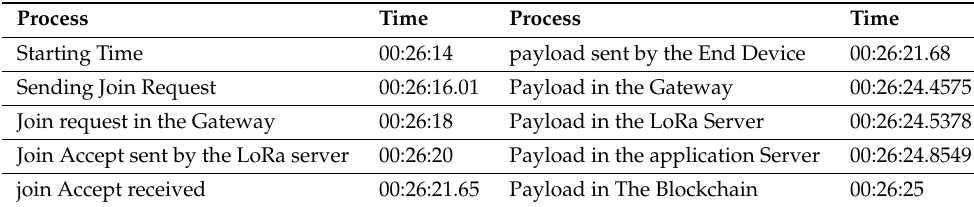
Table 5. Transmission Time Details through all the